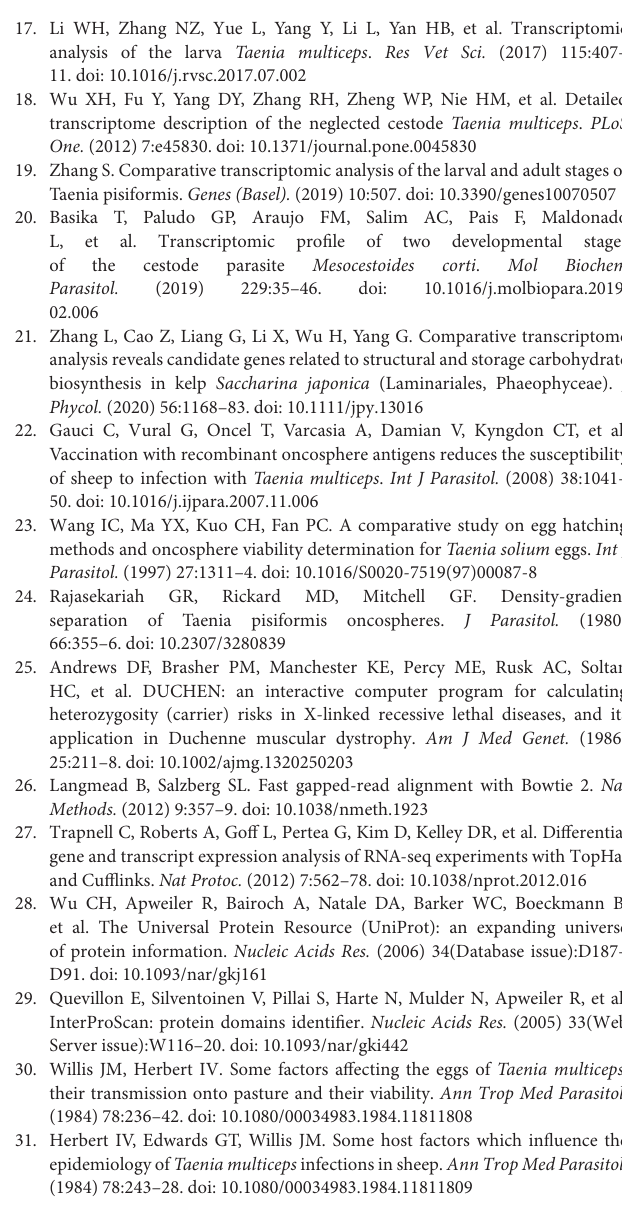
Supplementary Table 1 | Differentially expressed genes between the developmental stages or